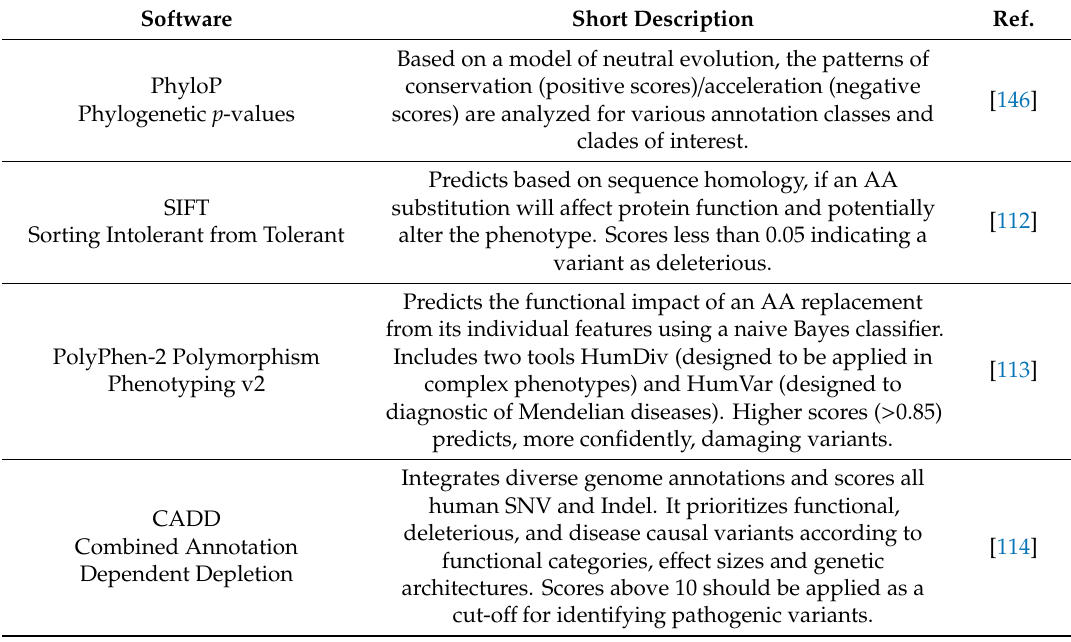
Table 1. List with examples of widely used tools to perform an NGS functional filter. Software Short Description